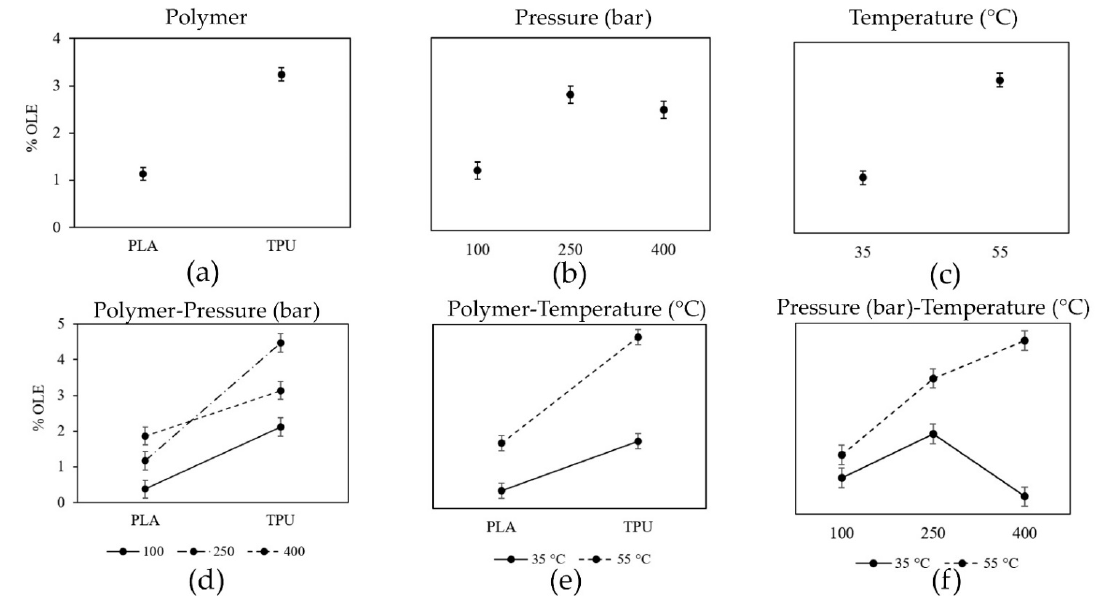
Figure 5. Plots of the multifactorial ANOVA analysis. Means plots for the statistically significant single factors: ( a ) polymer, ( b ) pressure and, ( c ) temperature; and interaction plots between two factors: ( d ) polymer-pressure, ( e ) polymer-temperature and ( f ) pressure-temperature, on the ethanolic OLE loading (%OLE). All impregnation runs were performed for 1 h. Non-parallel lines indicate an interaction between the factors.